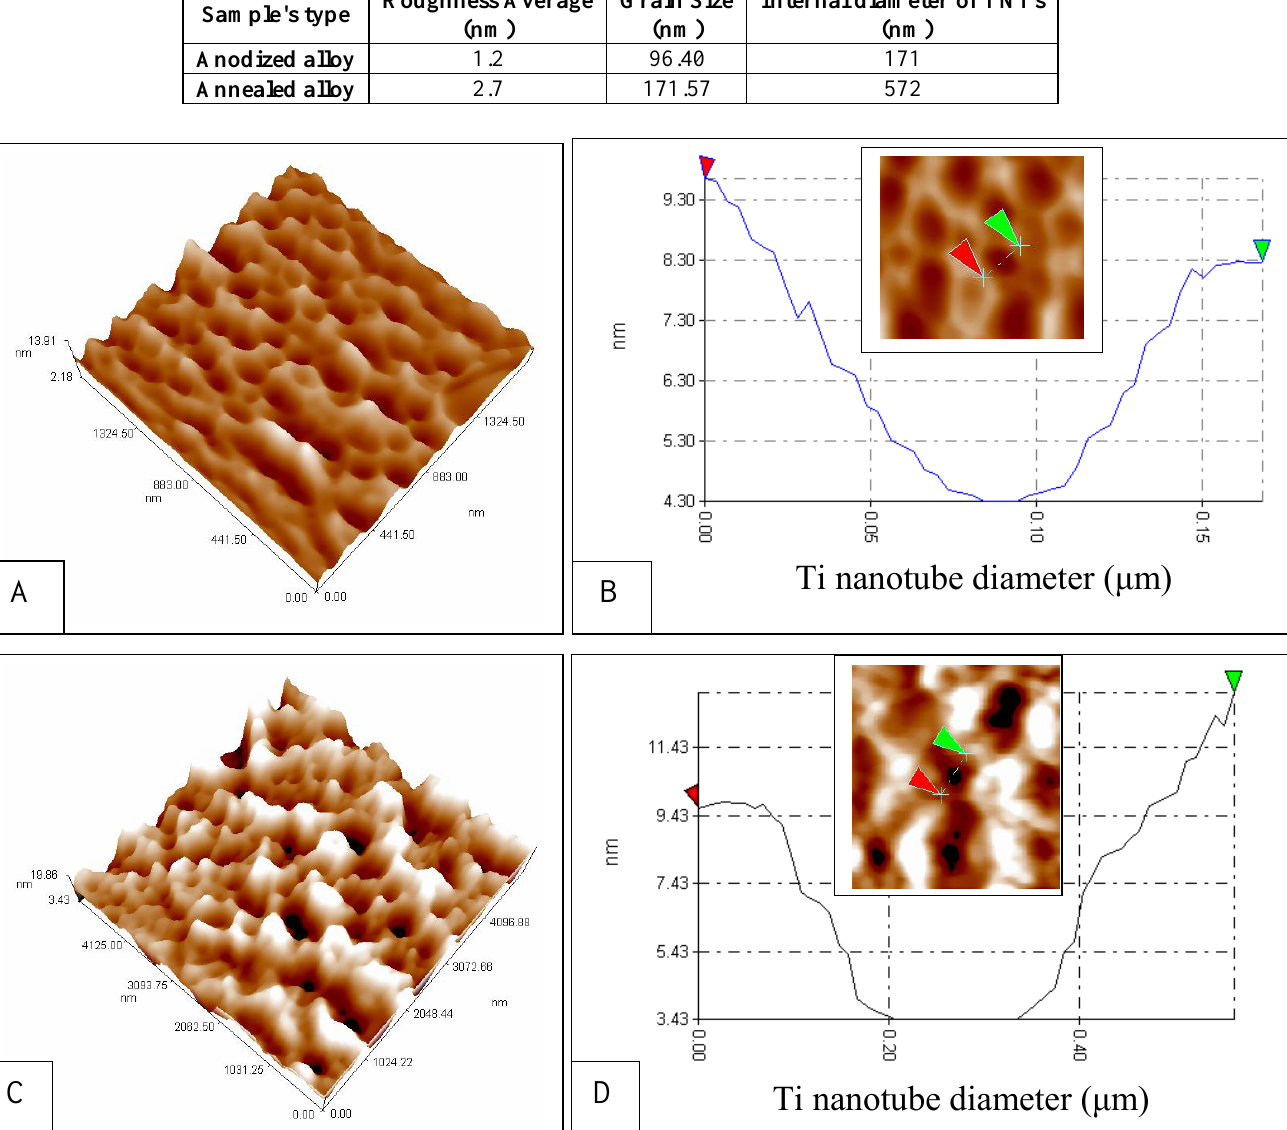
Figure 4: (A),(C):AFM images of anodized and annealed Ti-6Al-4V alloy respectively. (B),(D): Measurement of Ti–tube after anodic and annealing processes